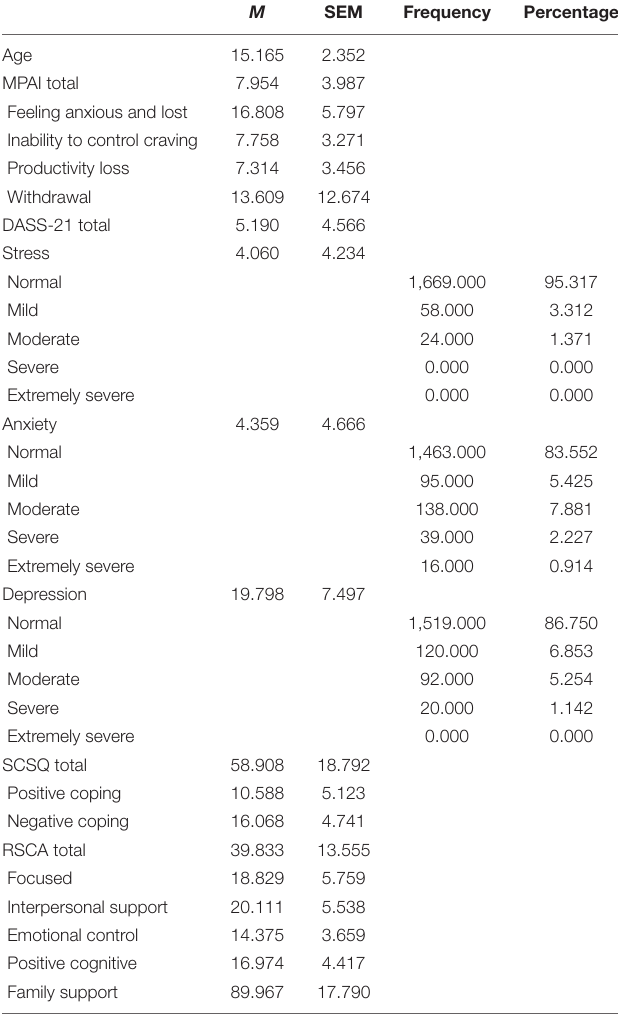
TABLE 4 | Results of the structural model: tests of hypothesized associations between